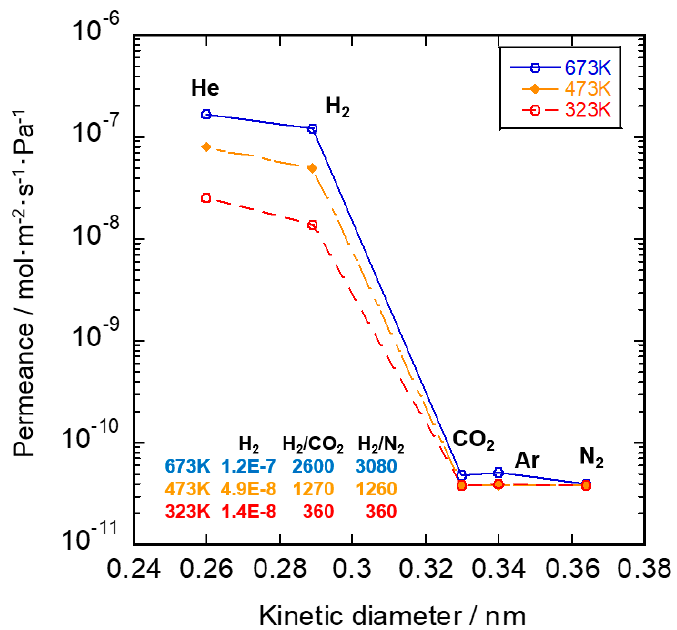
Figure 11. Single gas permeance of SiC membrane in the temperature range 323–673 K.